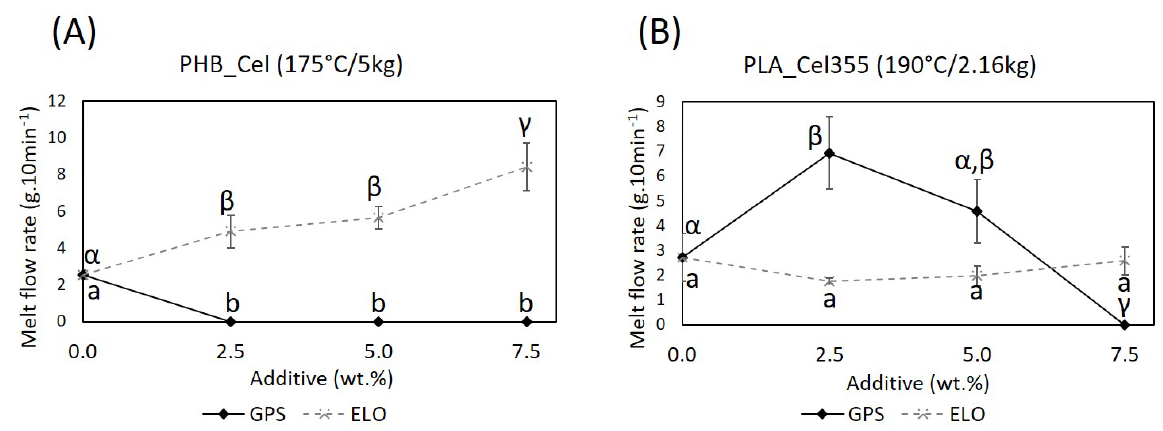
Figure 6. Melt flow rate of the PHB- ( A ) and PLA-based composites ( B ), without additives and with different loads of GPS and ELO additives (the lines are for visual guidance only). Different letters (a,b) or (α,β,γ) indicate statistically significant differences ( p < 0.05).